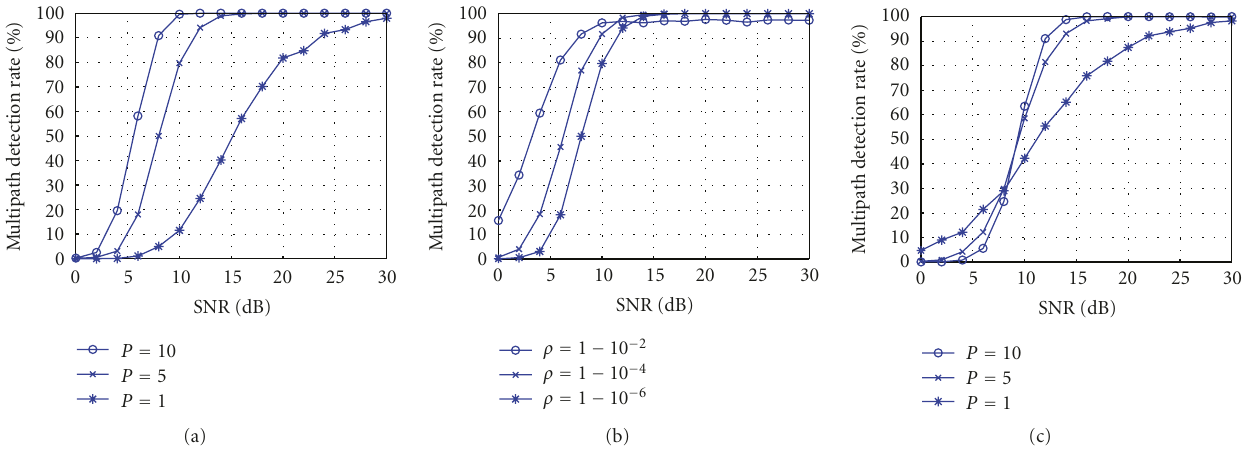
Figure 11: Multipath detection rates based on the EP. (a) Quantile-based model selection versus P : ρ = 1 − 10 − 6 , L = 5; (b) Quantile-based model selection versus ρ : P = 5, L = 5; (c) Negative log-evidence-based detection versus P